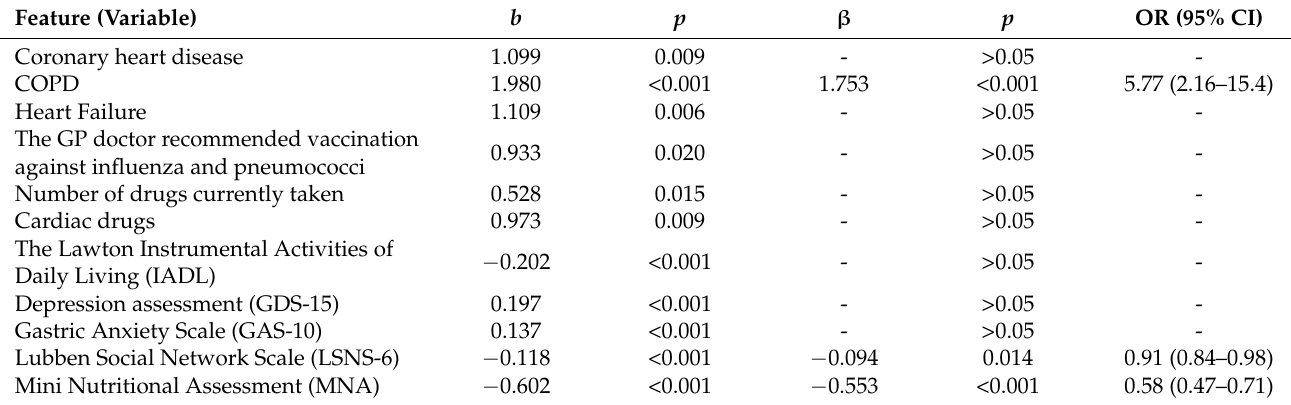
Table 4. Results of univariate and multivariate logistic regression of the answer to the question regarding the resignation of the admission to the Emergency Room due to the fear of COVID-19 infection in elderly patients and socio-demographic and clinical factors as well as the odds ratio [OR] and its 95% confidence interval [CI] [the most statistically significant ( p -value < 0.05) predictors of avoiding urgent medical care in elderly